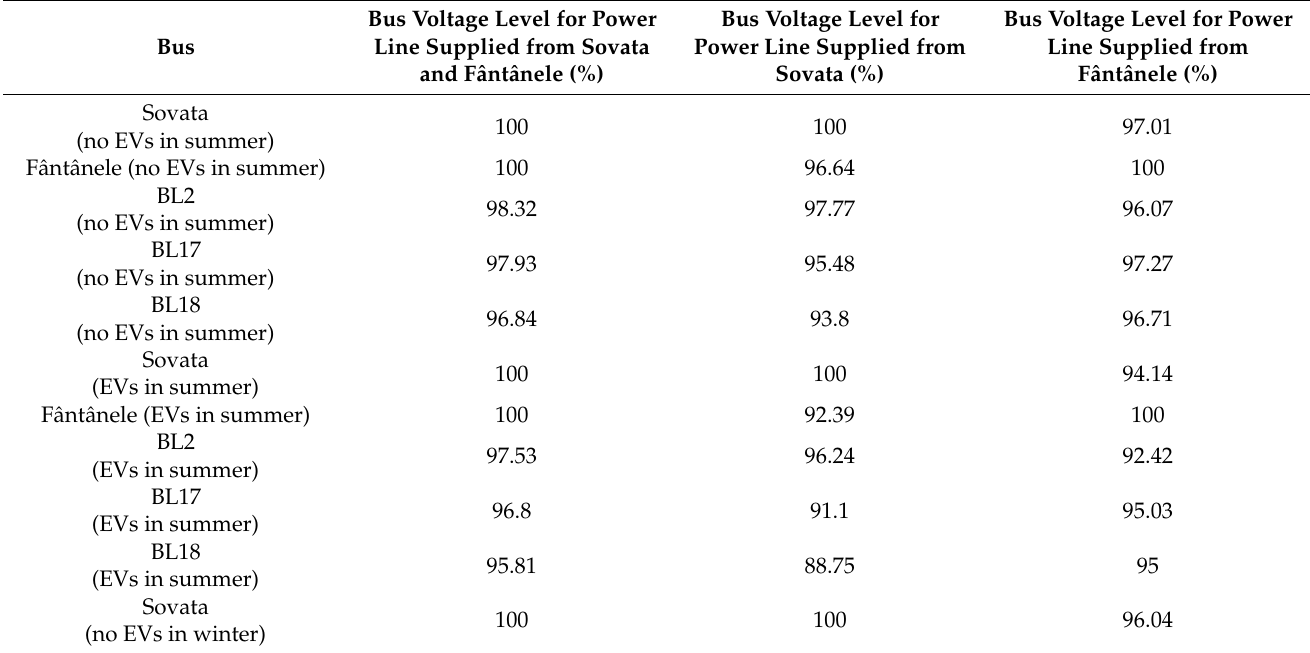
Table 14. Voltage level at 5:00 (scenario